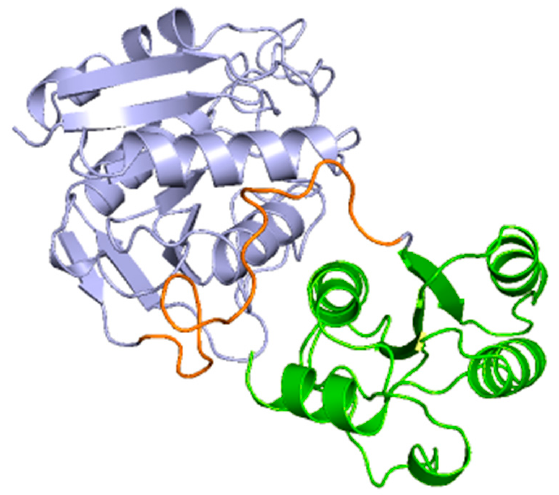
Figure 4. Subunit of chimeric humanized E. coli L-asparaginase with fragments of human L-asparaginase 4O0H. Subunit of the chimeric humanized 3ECA-derived chimeric enzyme is shown in independently folded three-dimensional conformation. The C-terminal end of the subunit with four α -helices and one parallel β -sheet is shown in green. The loop separating the two α / β domains formed by the subunit is shown in orange.